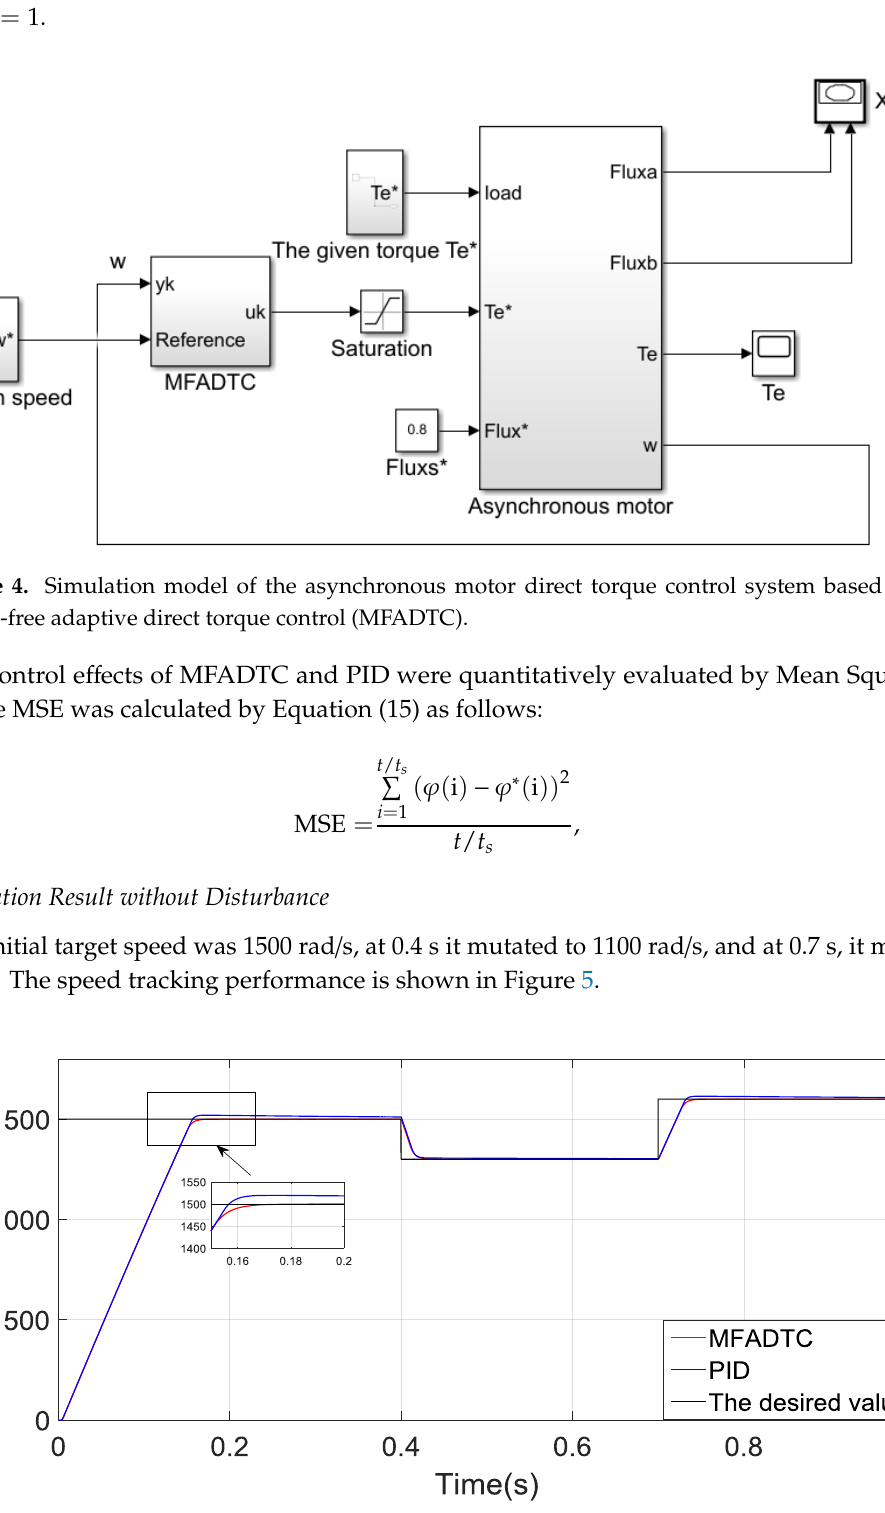
Figure 3. Simulation model of the asynchronous motor direct torque control system based on PID.